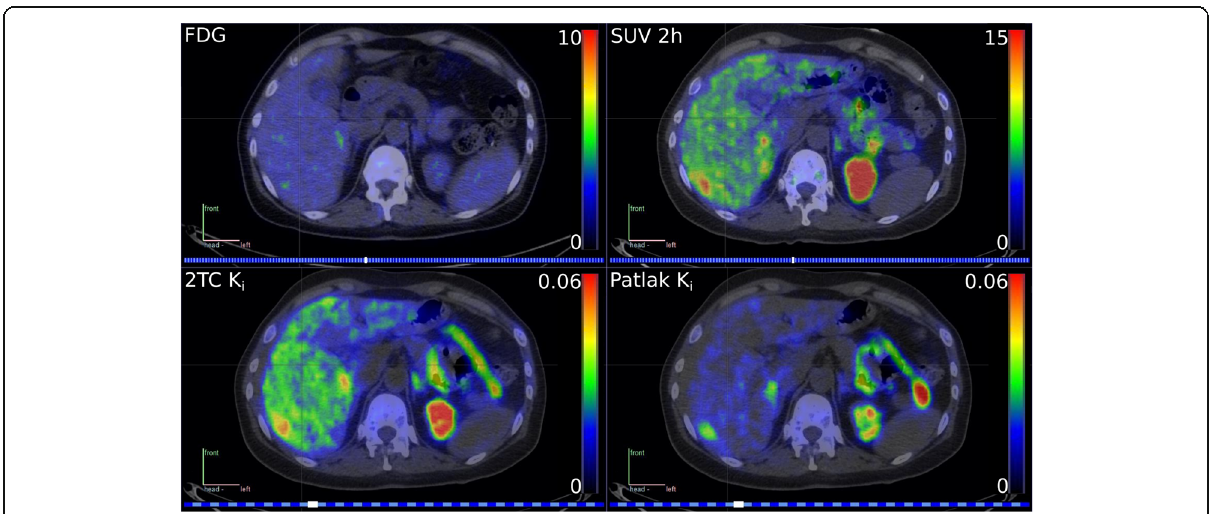
Fig. 8 FDG PET and ABY-025 PET SUV 2 h and parametric images of both Patlak K i and 2TC-3k K i in a breast cancer patient with multiple small liver